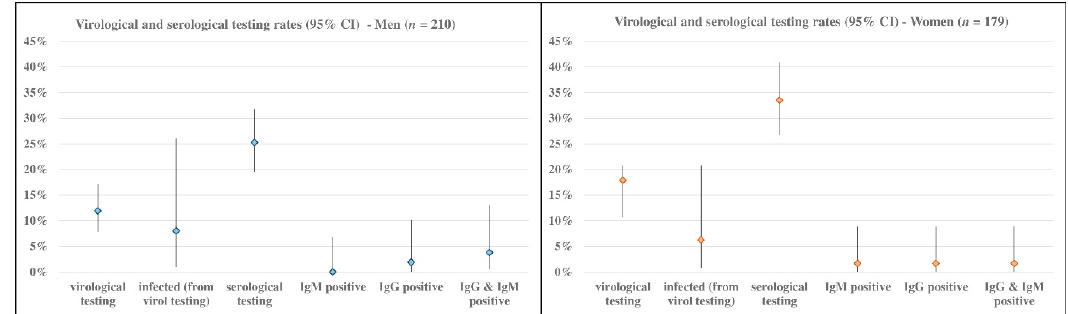
Figure 7. Dress-COV: virological and serological testing results.